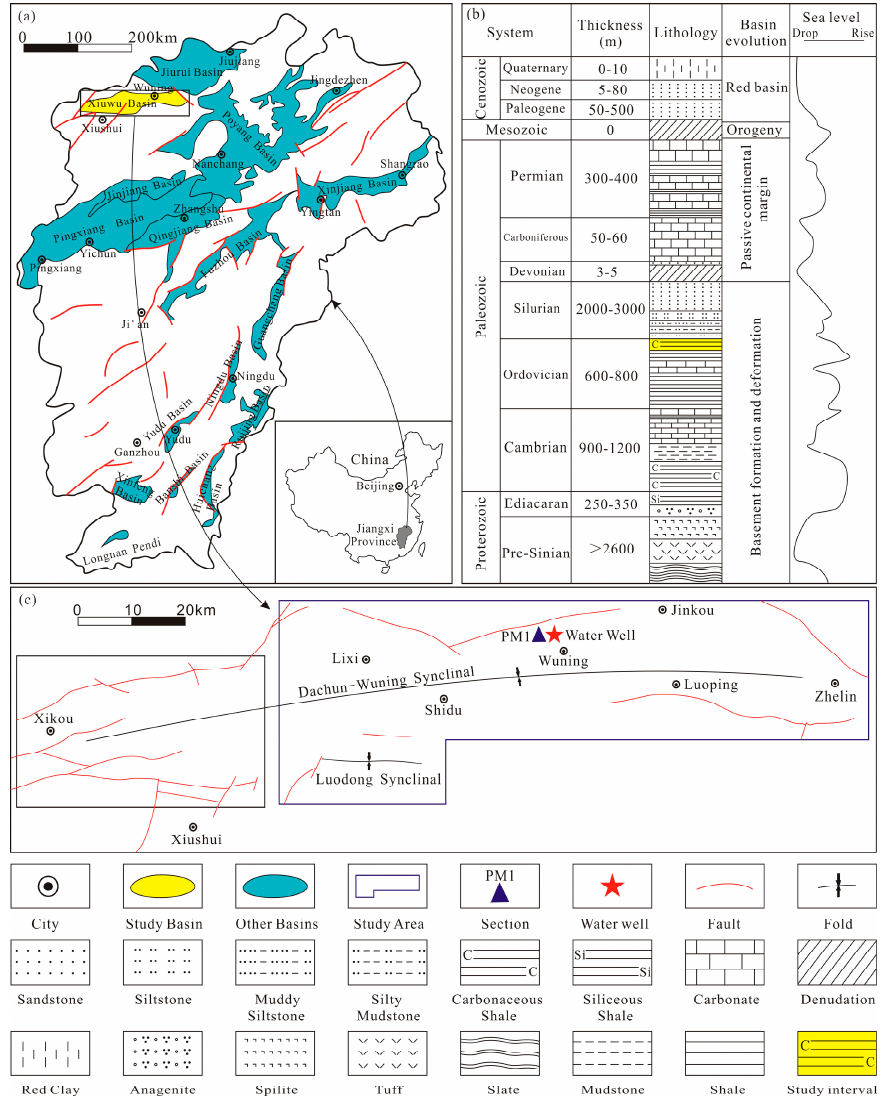
Figure 2. ( a ) The location of Xiuwu Basin, Jiangxi Province, China; ( b ) the structural characteristics of the study area and the site of the water well; ( c ) schematic diagram showing the stratigraphy and basin evolution of Xiuwu Basin.